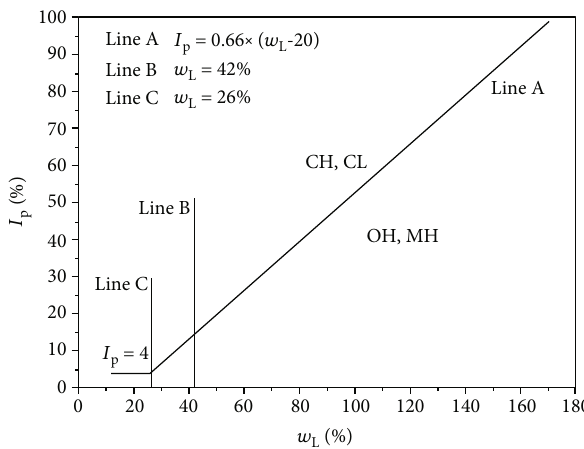
Figure 6: Casagrande plasticity of deep-sea sediments.